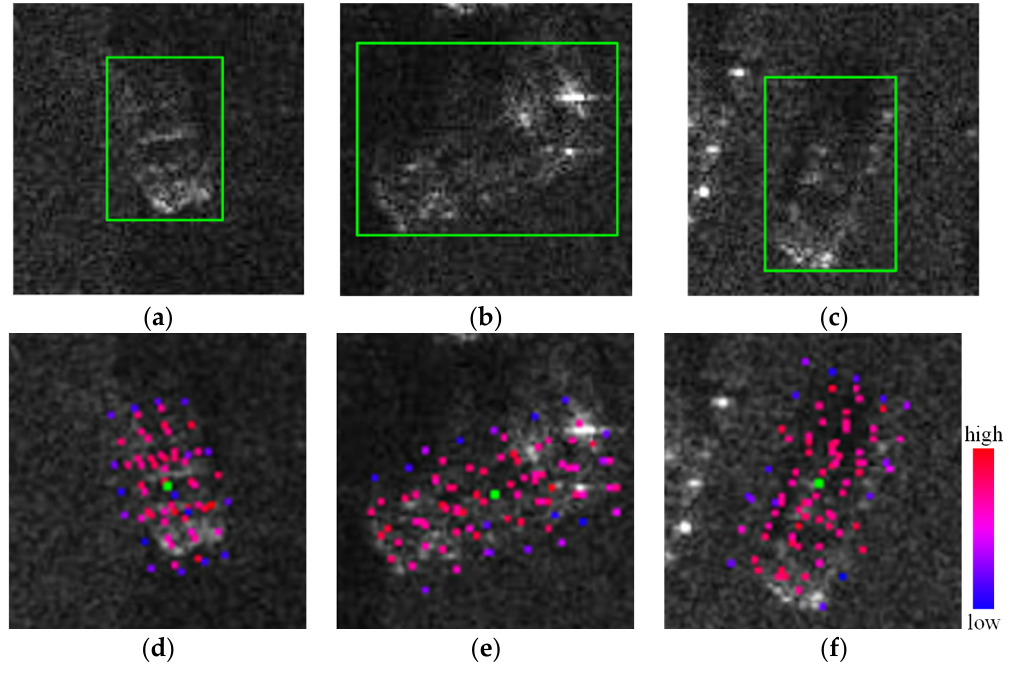
Figure 6. SAR chips of vehicle targets and the sampling locations (9 2 = 81 points in each SAR chip) in two levels of 3 × 3 RIRConv kernels. ( a , b , c ) SAR chips of vehicle targets. ( d , e , f ) Sampling locations in two levels of 3 3 × RIRConv kernels.